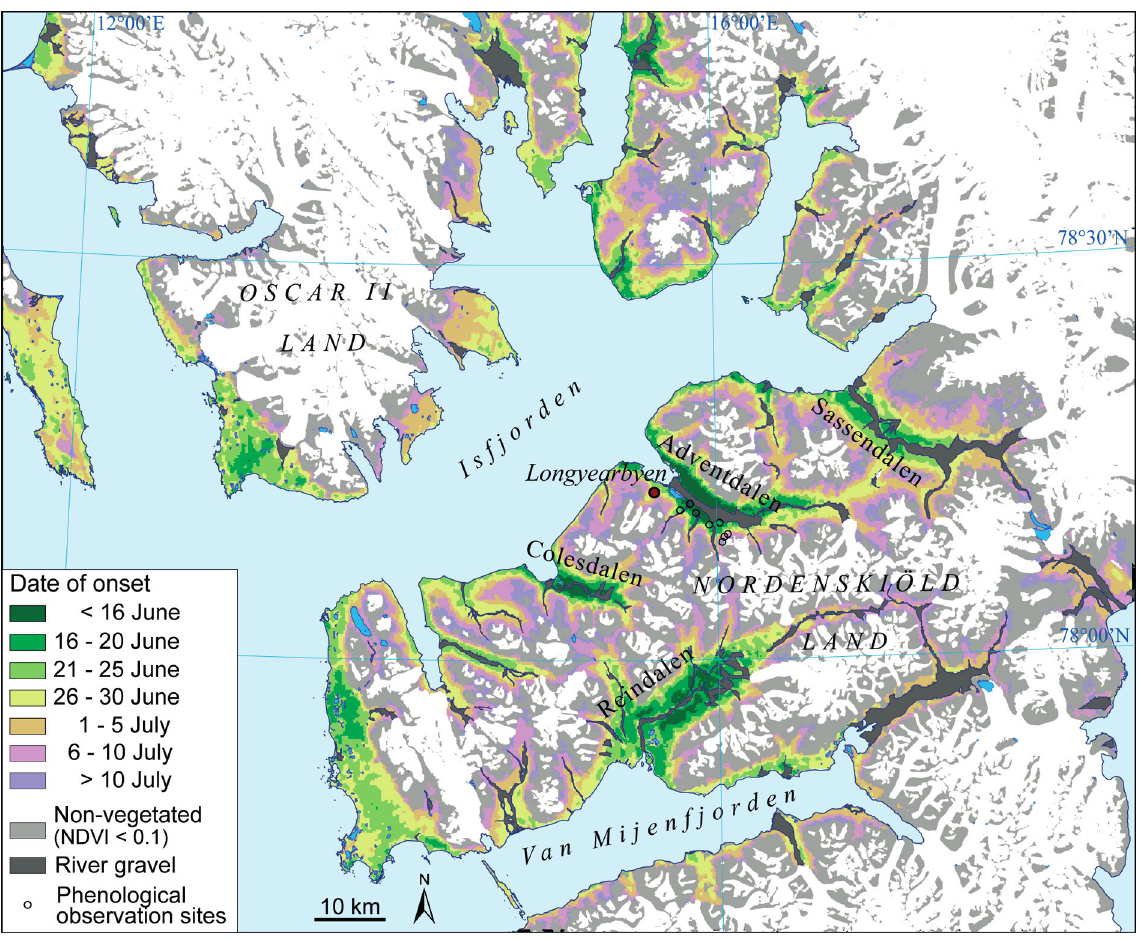
Figure 6. Time of onset of the growing season of central parts of Svalbard, based on mean values from the MODIS-NDVI dataset for the period